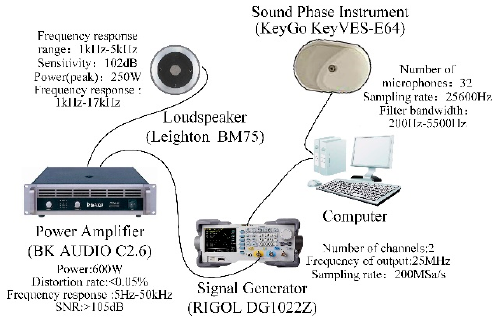
Figure 13. Sound source positioning experiment system.